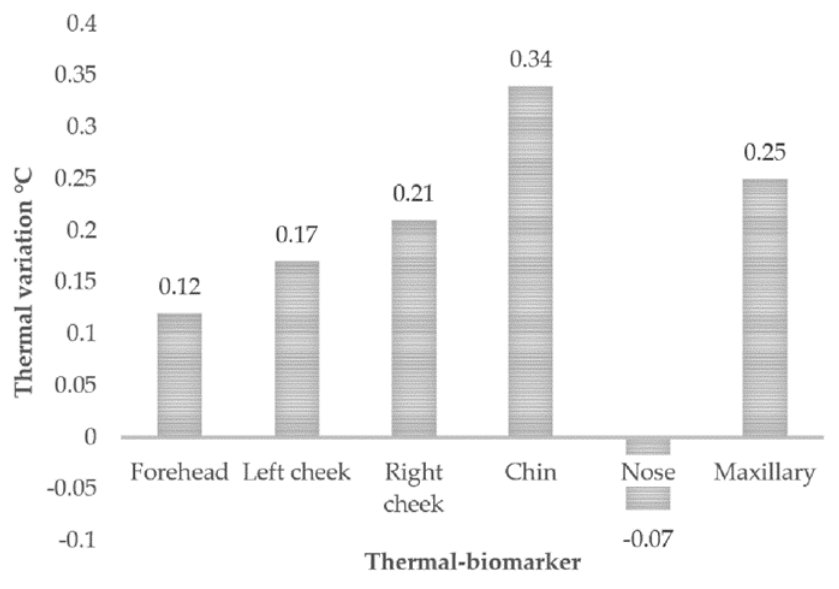
Figure 10. Thermal variation in the six thermal biomarkers.